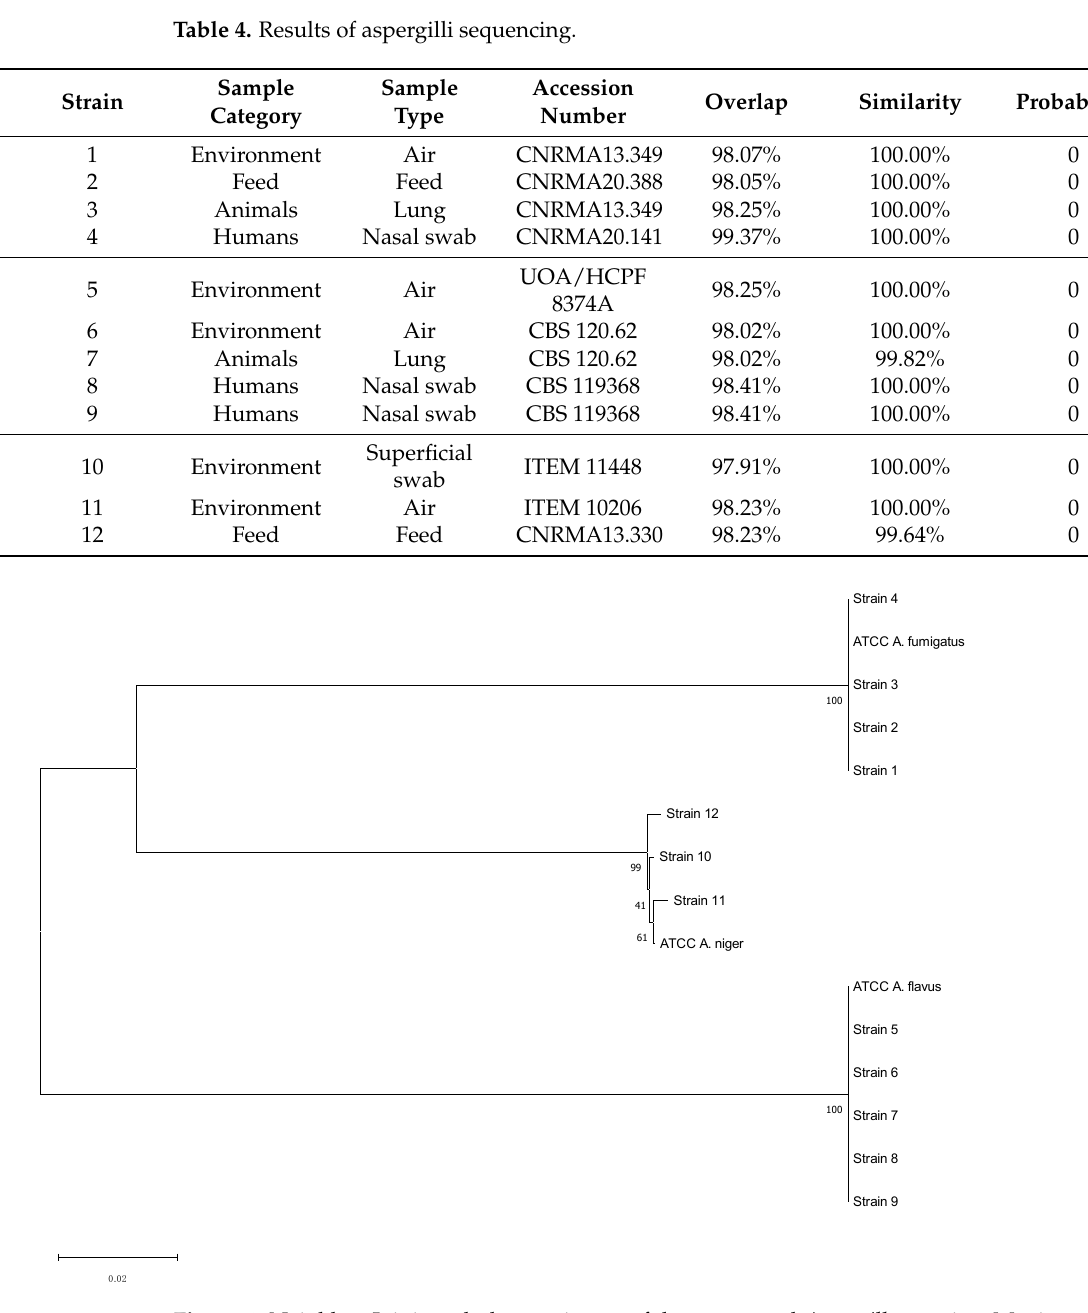
Figure 4. Neighbor-Joining phylogenetic tree of the sequenced Aspergillus strains. Maximum Composite Likelihood method, 1000 bootstraps (MEGA11 Software).